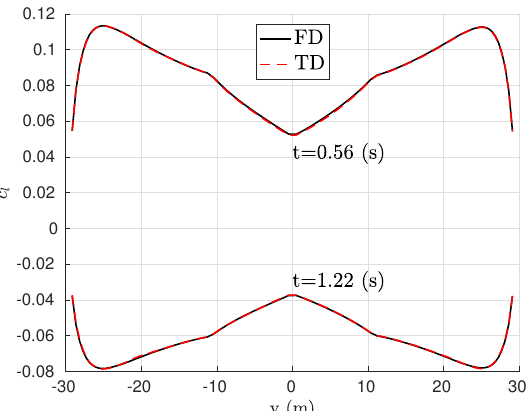
Figure 15. Incremental lift coefficient c l over the complete wing component at different time instants for M ∞ = 0.85, h = 7640 (m), H = 106.68 (m) and α eq = 1 (deg). Two rigid-body modes and 16 flexible modes considered. Results obtained with the generalized state-space model in the time domain (TD) of 231 states compared to the reference model in the frequency domain (FD).